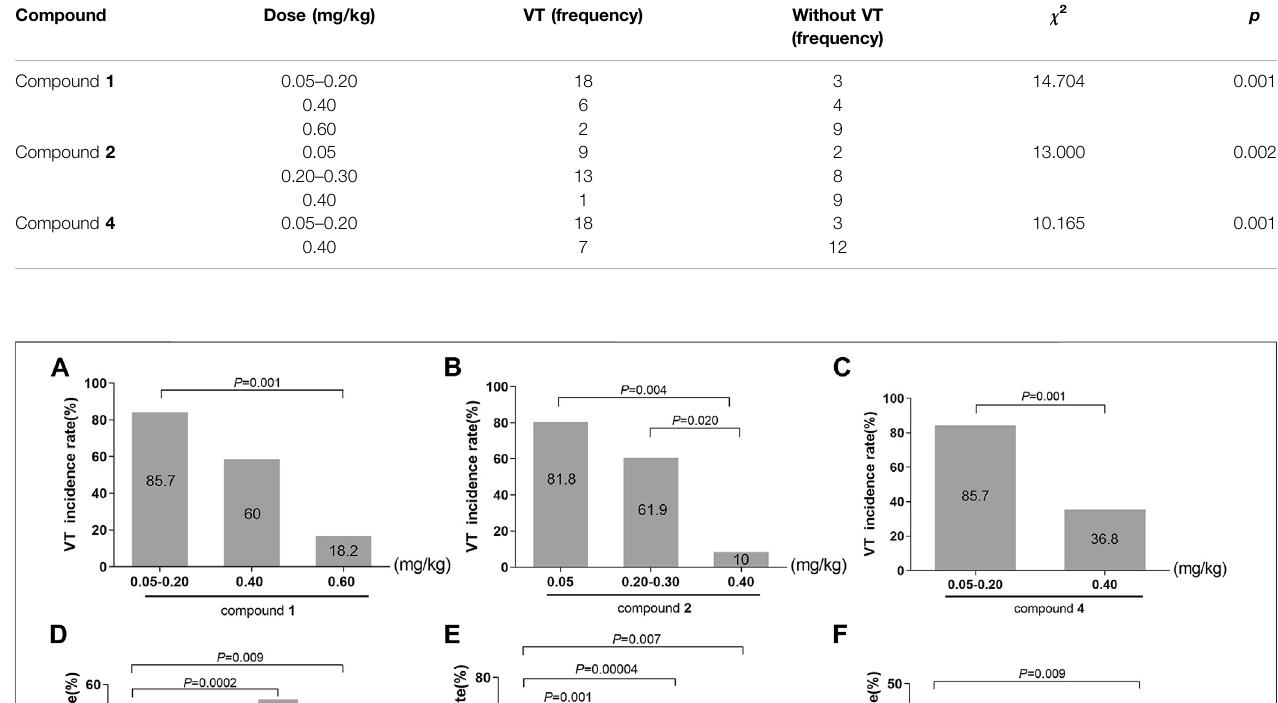
a marked difference in the incidence of VT among the three groups ( χ 2 (cid:2) 13.000, p (cid:2) 0.002). In comparison with the